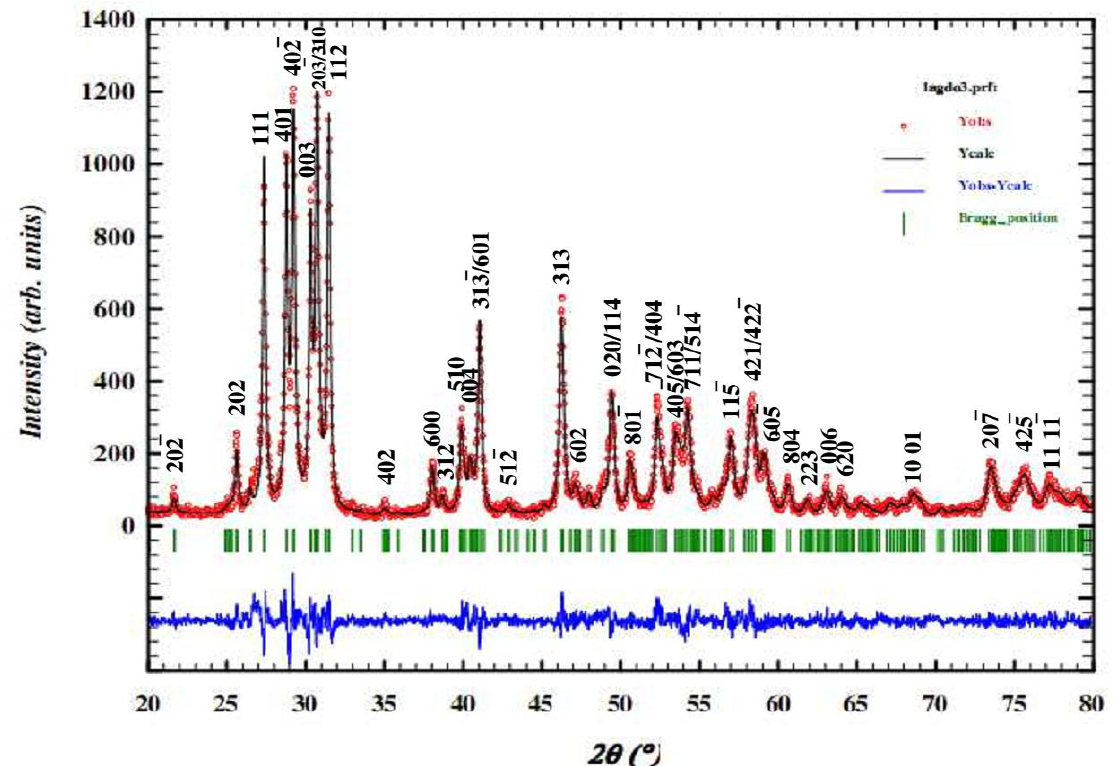
Figure 1. The experimental and pseudo-Voigt modeled diffraction patterns of LaGdO along with peak indices/index data after final Rietveld least squares